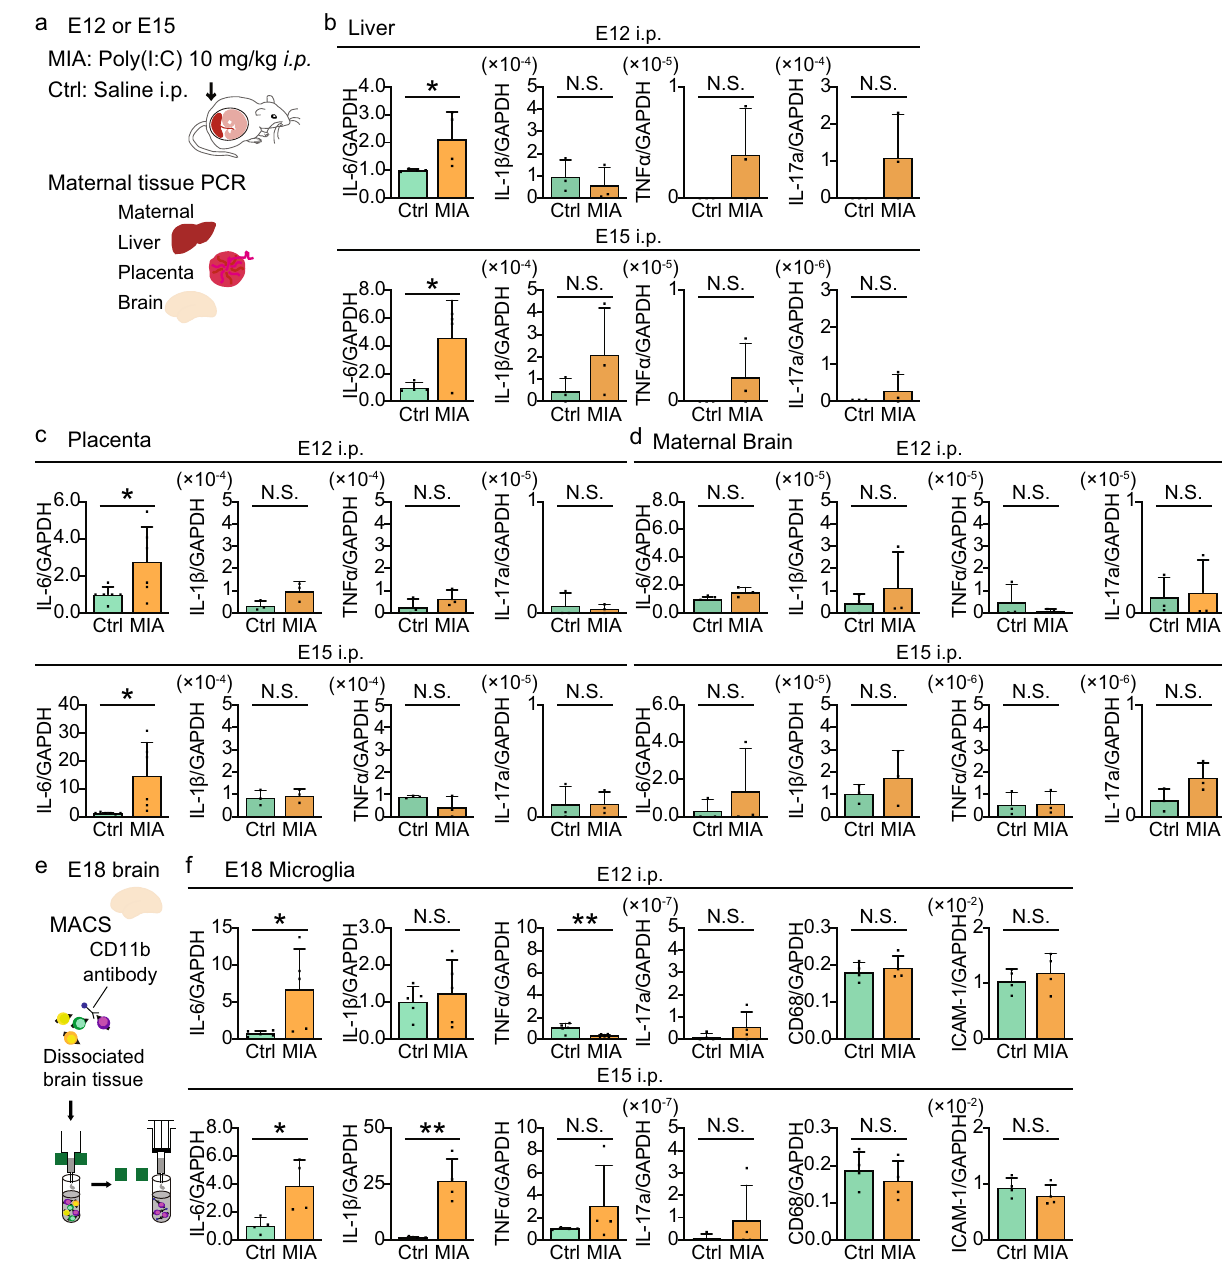
Figure 1. Maternal immune activation at E12 and E15 causes an altered biochemical phenotype in E18 fetal microglia. ( a ) Experimental scheme showing MIA induced in mothers by Poly(I:C) injection ( i.p. ) at gestational day 12 or 15 (E12, E15) and subsequent maternal tissue extraction. ( b – d ) Relative cytokine mRNA expression levels in maternal liver (IL-6: n = 4 mice in each group; IL-1β, TNFα and IL-17a: n = 3 mice in each group), placenta (IL-6: n = 6 mice in each group; IL-1β, TNFα and IL-17a: n = 3 mice in each group) and brain ( n = 3 mice in each group). Control (Ctrl: saline -injected) versus MIA (E12 and E15 Poly(I:C) -injected) mice. ( e ) Experimental schema showing extraction of microglia (CD11b positive cells) from fetal brain. ( f ) Relative cytokine mRNA expression levels in E18 microglia (IL-6, IL-1β and TNFα: n = pooled embryos from 5 (E12) or 4 (E15) mice; IL-17a, CD68 and ICAM-1: n = pooled embryos from 2 mice in each group). In ( b – d , f ) Ctrl represents age-matched saline injection and MIA is E12 or E15 Poly(I:C) -injected mice. Graphs represent the mean ± standard deviation, while dots represent data from each mouse. * P < 0.05, ** P < 0.01 and N.S.: not significant, unpaired t